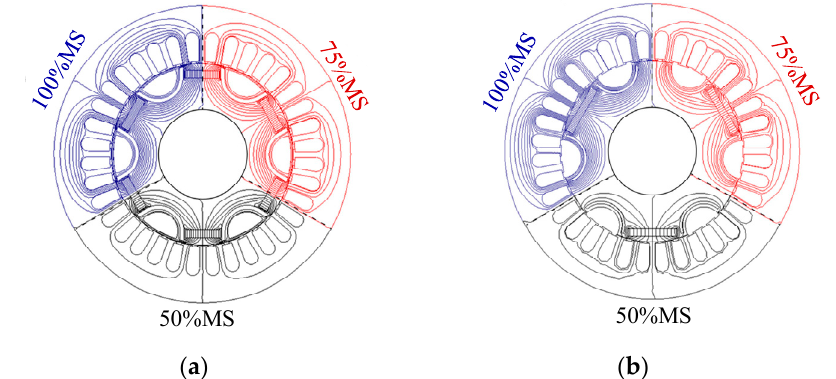
Figure 5. Flux line distributions under different MSs. ( a ) FIMM; ( b ) CP-FIMM.